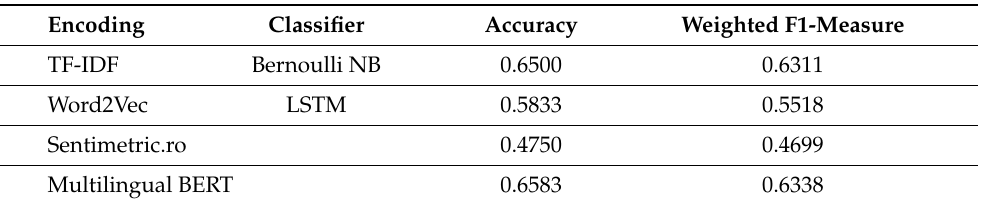
Table 4. Performance of various models (accuracy and weighted F1-measure) on a Romanian dataset with aviation industry-specific tweets.